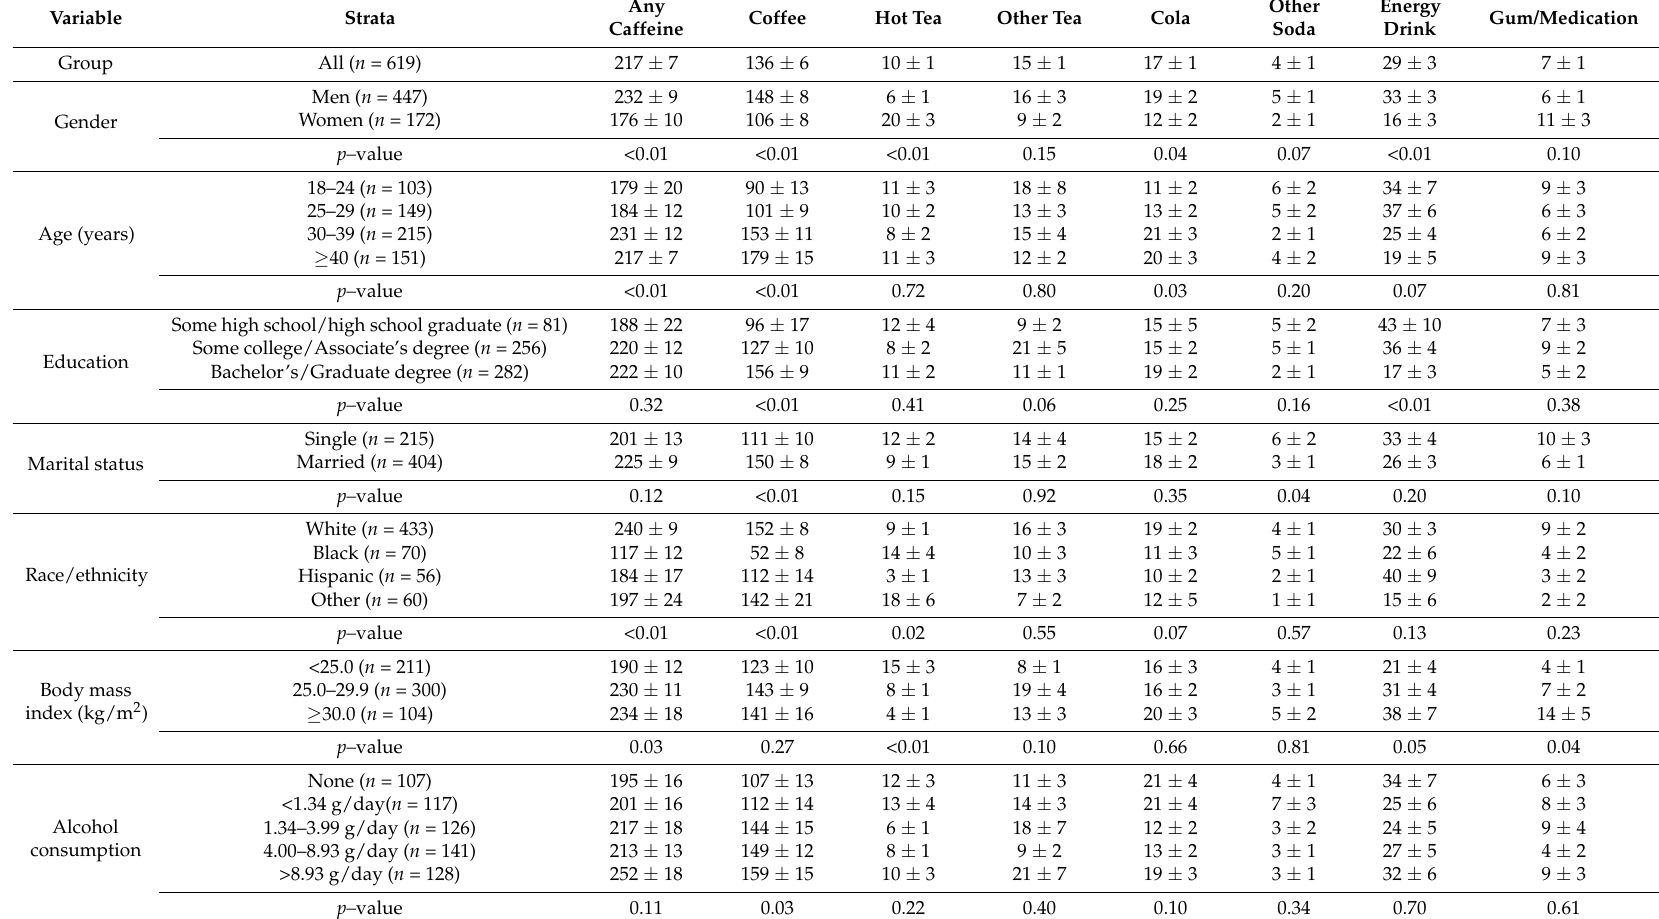
Table 6. Caffeine consumption (mean ± SE mg/day) of Navy consumers ( ≥ 1 time/week) by demographic, lifestyle, and military characteristics ( p -values are from one-way analysis of